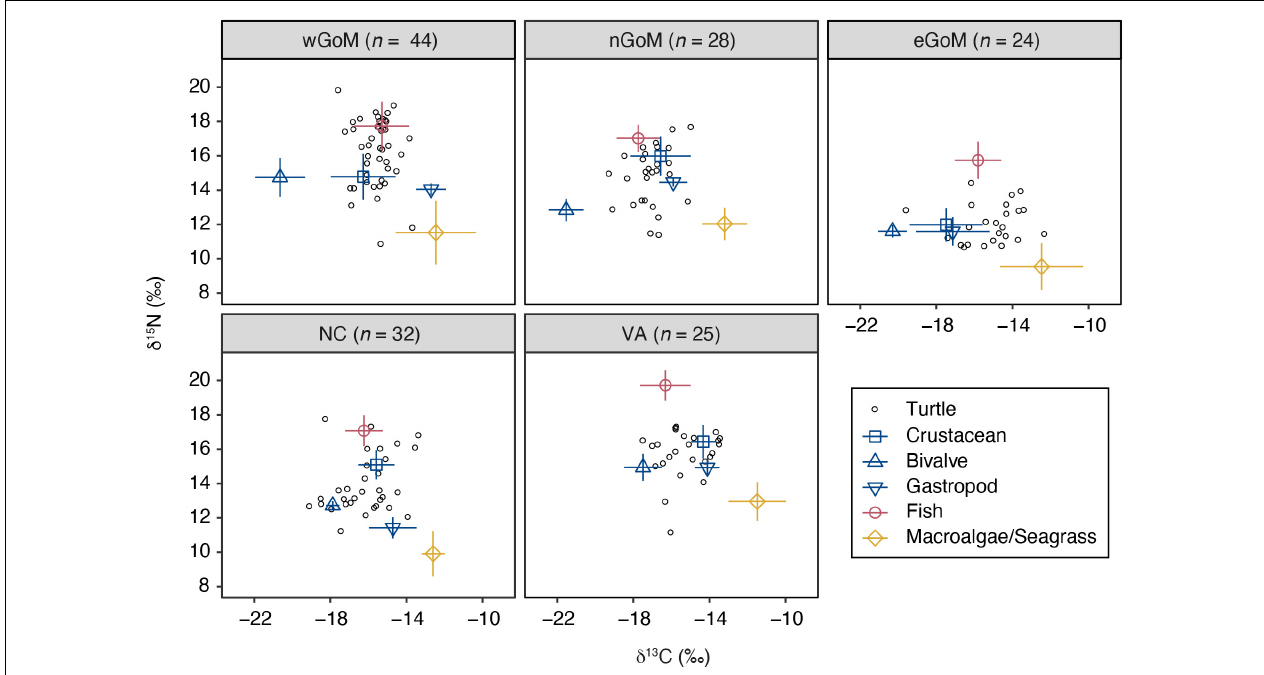
FIGURE 2 | Biplots of δ 13 C and δ 15 N values for Kemp’s ridley sea turtles ( open circles ) and their potential prey groups (mean ± SD) by geographic region. Turtle sample sizes are presented at the top of each plot. Data are for the most recently deposited growth layer prior to death only. Prey values are corrected for trophic discrimination factors ( (cid:49) 13 C =